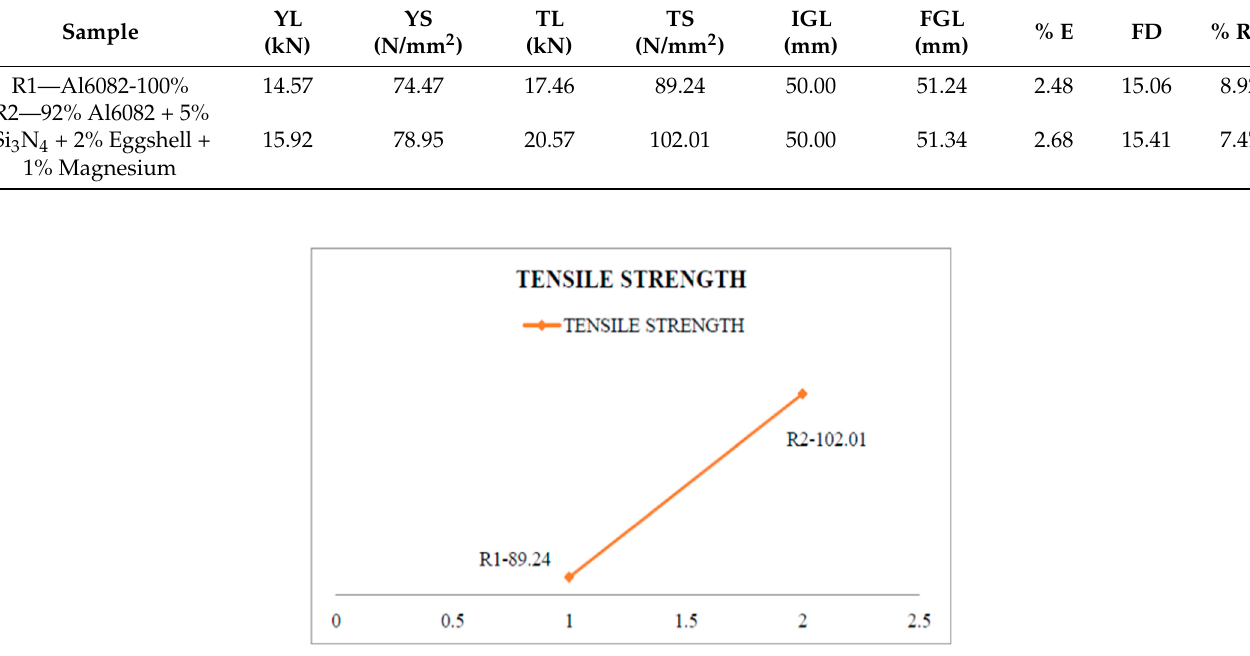
Figure 5. Tensile strength graph.